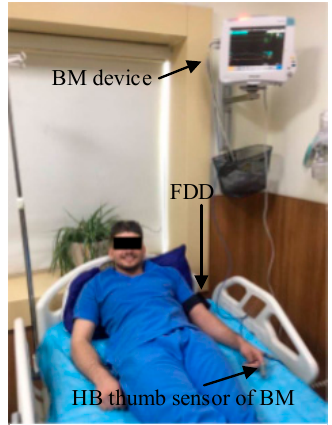
Figure 6. Performance evaluation comparing the FDD and a BM device.